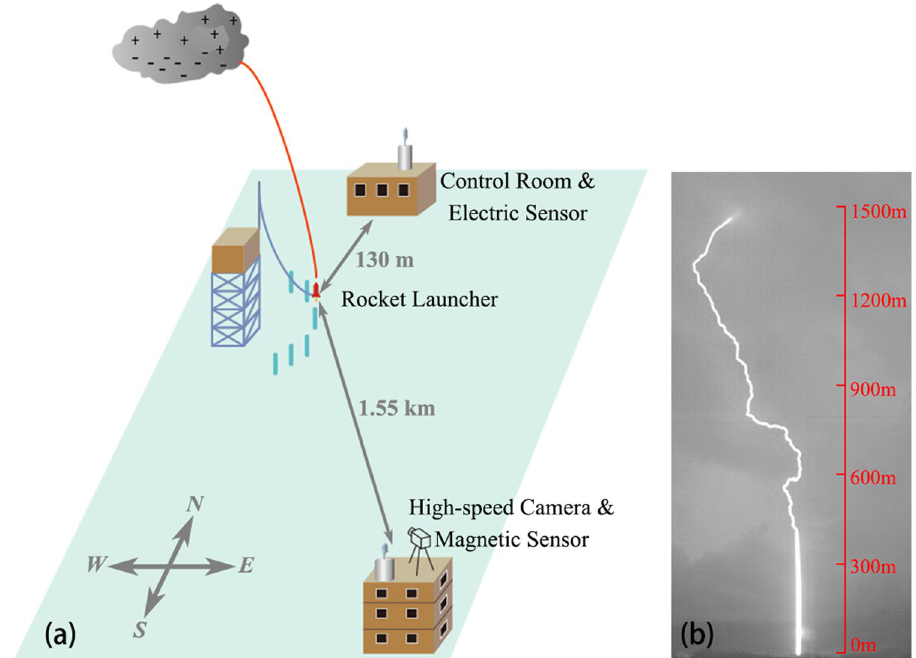
Figure 1. Sketch of the equipment including the high-speed camera, magnetic sensor, rocket launcher and electric sensor. Artificially Triggered lightning Experiment had been carried out in the summer of 2019 in Guangzhou Field Experiment Site for Lightning Research and Testing (GFESLRT), and the flash (F201906301713) analyzed in the letter was triggered at 17:13:13 on 30 June, 2019. ( a ) The layout of the equipment including the high-speed camera, magnetic sensor and electric sensor. ( b ) The image of the lightning channel and the corresponding